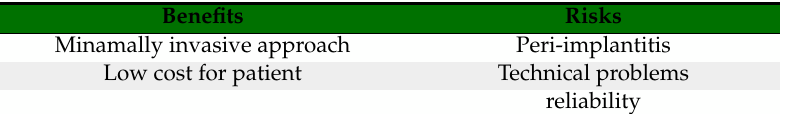
Figure 5. Intraoral picture of the implant positions and the multi-unit abutment screwed on. Table 1. Implant retention.